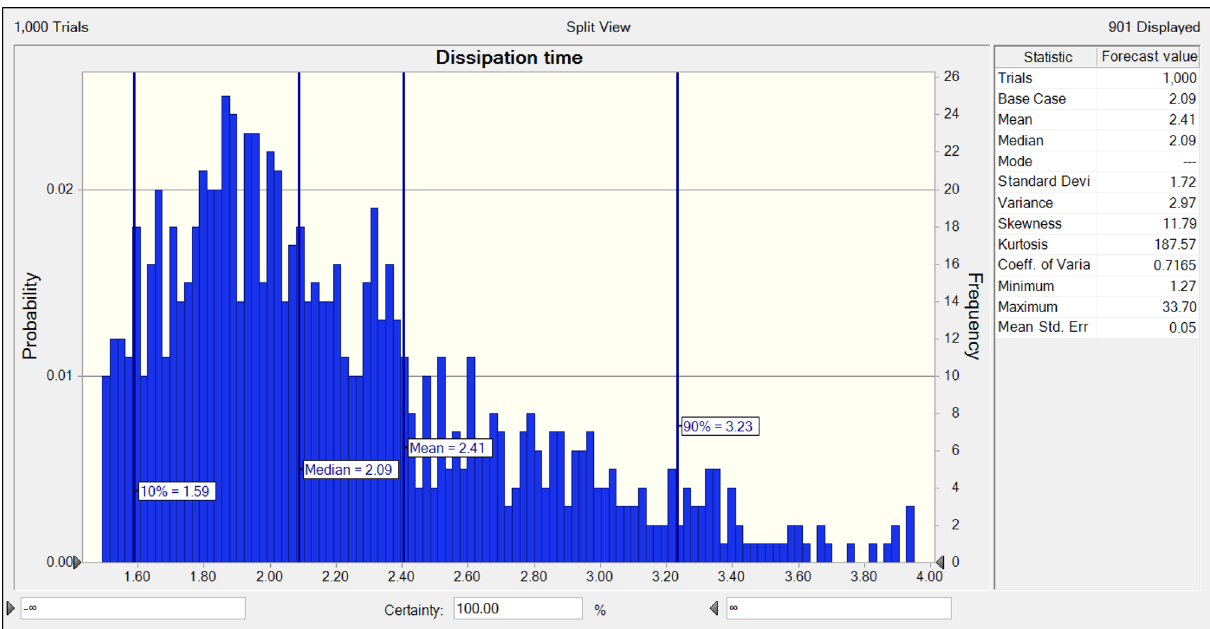
Fig. 10 Simulation results of dissipation time ( T